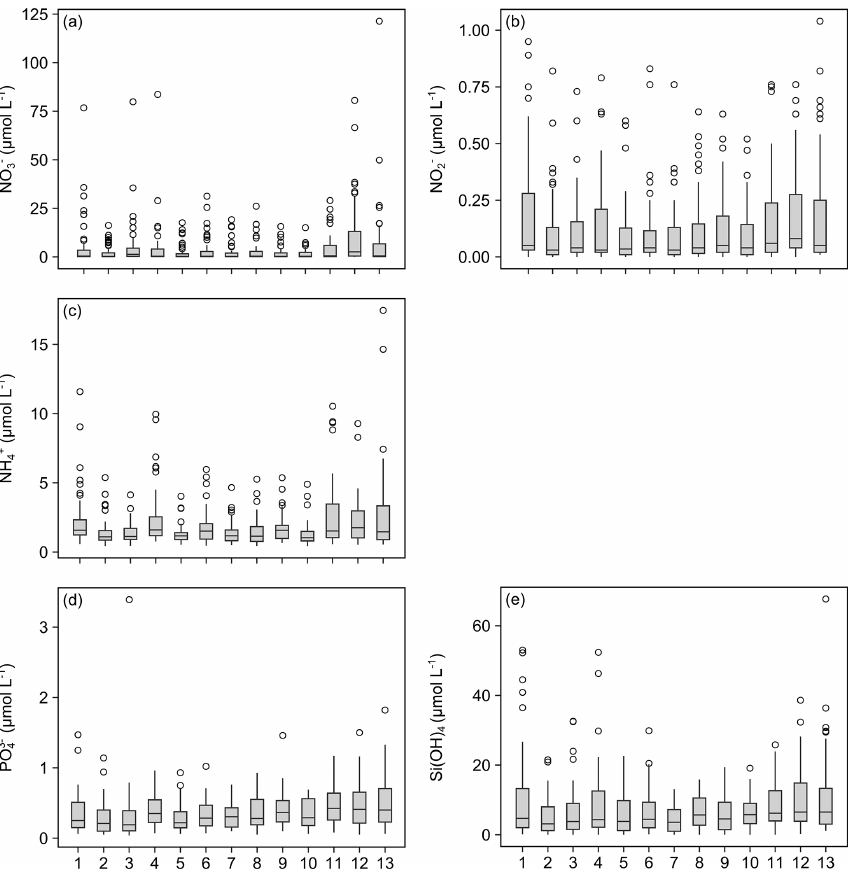
Figure 5. Box plots of measured dissolved inorganic nutrient concentrations. Data for nitrate (a) , nitrite (b) , ammonia (c) , phosphate (d) and silicate (e) concentrations are presented. X axis indicates station numbers. Boxes indicate the median and first and third quartiles. Whiskers show values within and dots values outside 1.5 times the interquartile range. Table 5. Summary of measured dissolved inorganic nutrient concentrations in water samples from the monitoring stations. For each station and nutrient, median, minimum and maximum concentrations are